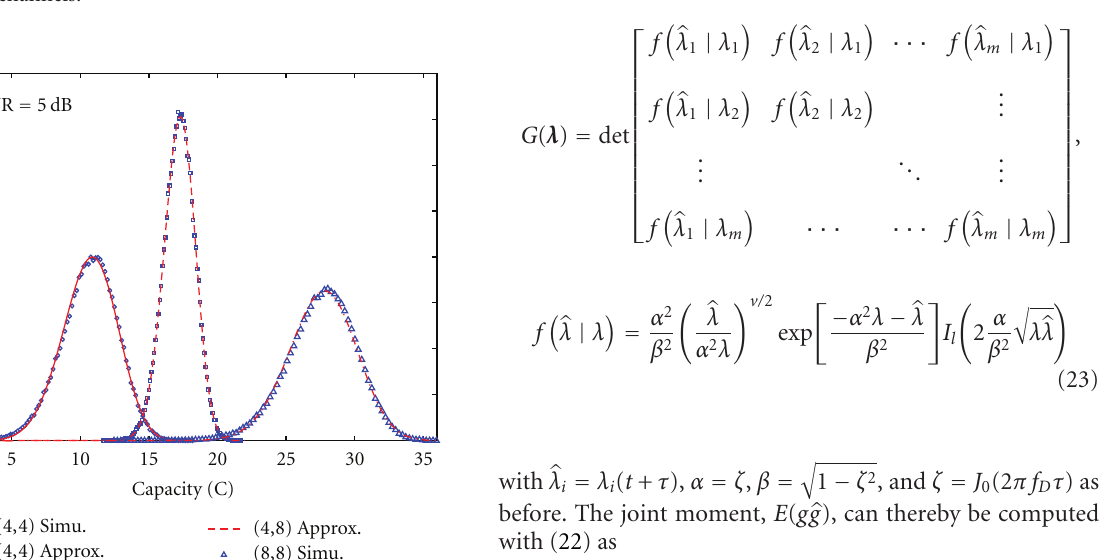
Figure 4: Comparison between simulation and Gamma approxi- mation results for distributions of eigenvalue geometric means (link gains of GMD-based transceivers) in (4,4), (4,8), and (8,8) MIMO Rayleigh fading channels.